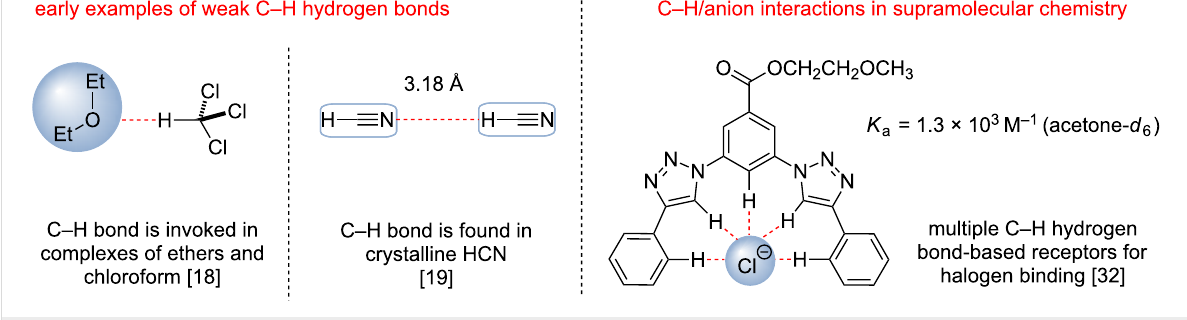
Figure 2: Early examples of C–H hydrogen bonds and their recent use in supramolecular chemistry [18,19,32-34].